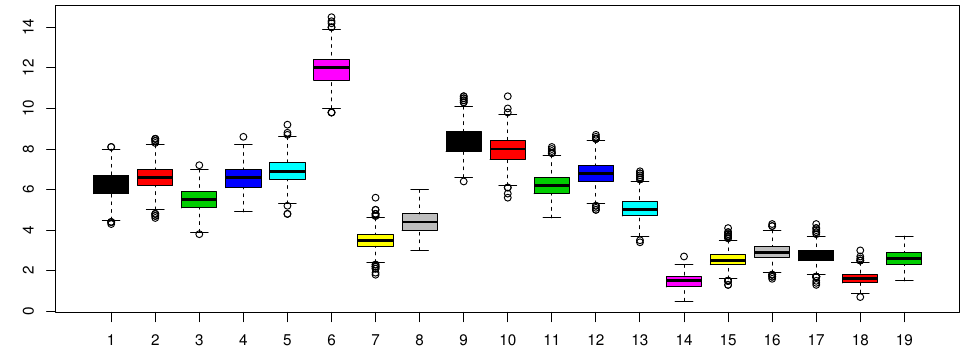
Figure 6. Lombardy, bootstrapped observations referring to 2015. Distribution of the number of meteorological stations in each of the 19 temperature classes.